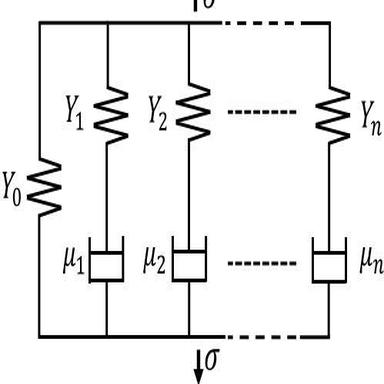
Schematic of the generalized Maxwell model for viscoelastic materials.